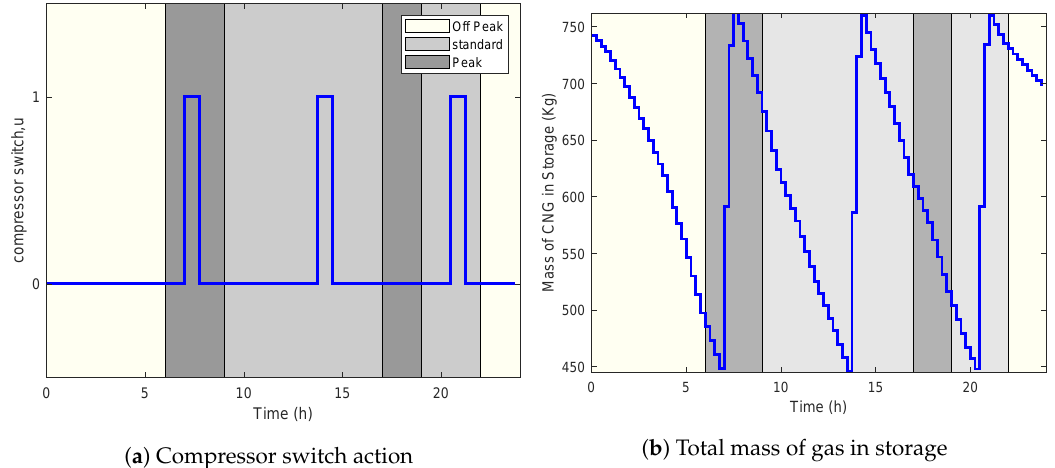
( b ) Total mass of gas in storage Figure 5. Baseline Operation